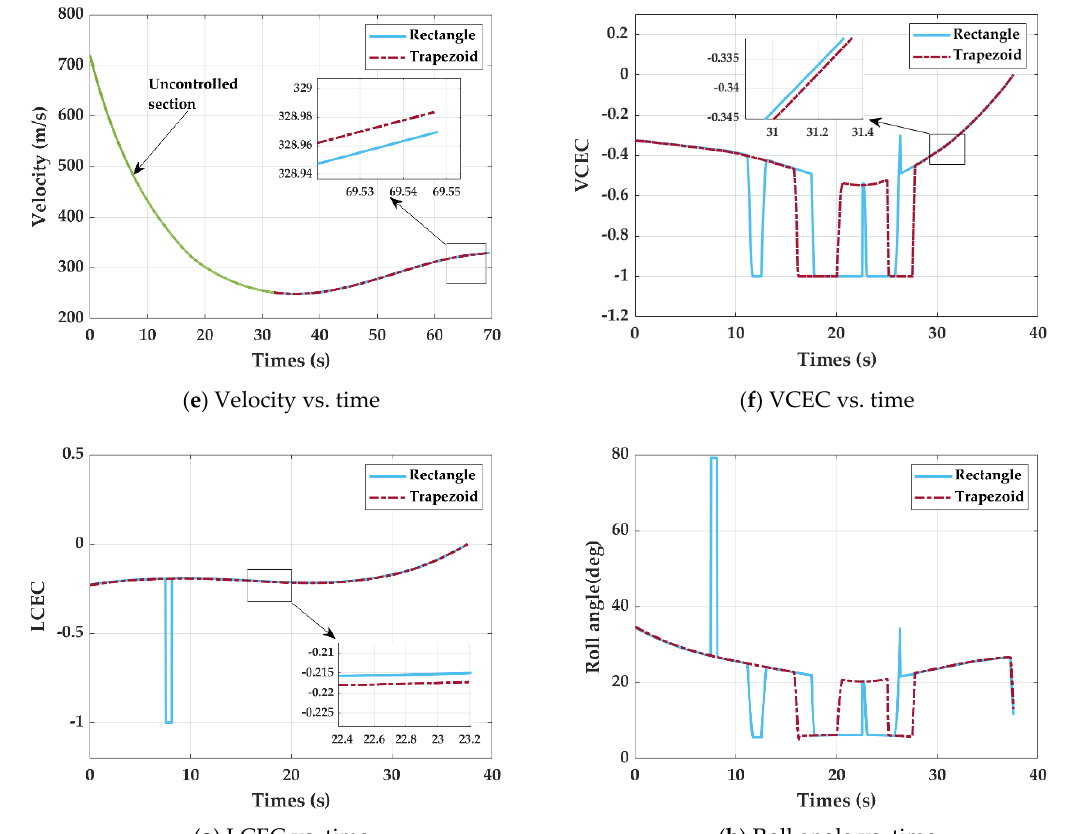
Figure 8. Trajectory optimization of different canards.